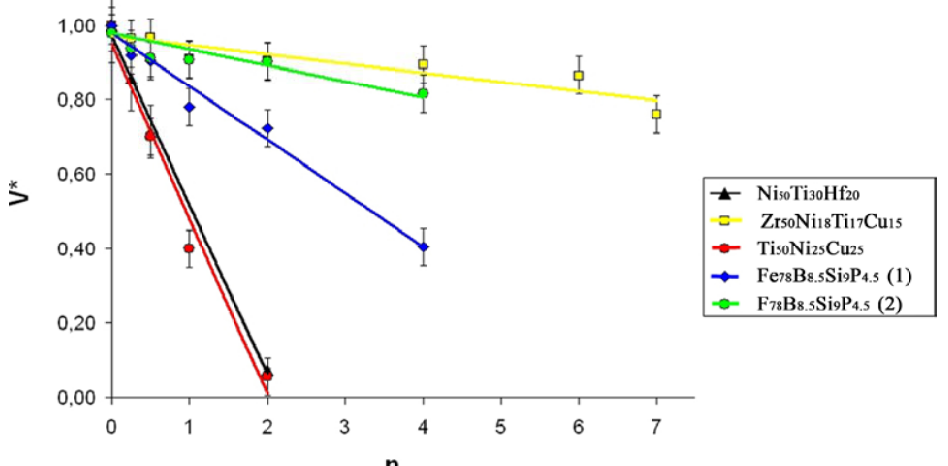
Fig. 1. Dependence of the change in the reduced volume fraction of the crystalline phase V* for the inves- tigated alloys on the value of n .